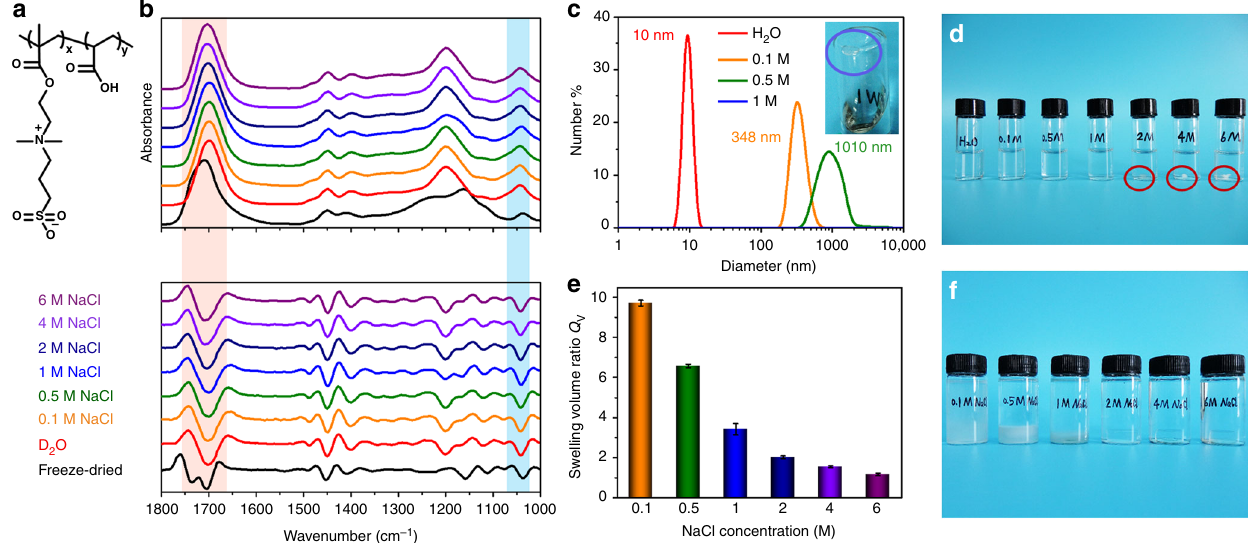
Fig. 1 Con fi rmation of multiple dynamic interactions in the supramolecular networks. a The chemical structure of the polyelectrolyte (PAA-co-DMAPS) synthesized in this work. b ATR-FTIR spectra (in the regions of 1800 – 1000 cm − 1 ) of the freeze-dried PAA-co-DMAPS copolymer and the supramolecular polyelectrolyte hydrogels equilibrated in D 2 O with different NaCl concentrations and their corresponding second derivative curves. c Hydrodynamic diameters of the freeze-dried PAA-co-DMAPS copolymer in aqueous solutions (0.1 wt%) with different NaCl concentrations (0, 0.1, 0.5, and 1 M). The inset photo shows precipitates are observed in 1 M NaCl. d A photo of the PAA-co-DMAPS copolymer equilibrated in aqueous solutions (0.1 wt%) with different NaCl concentrations. e Swelling volume ratios of the polyelectrolyte hydrogels equilibrated in NaCl aqueous solutions with different concentrations. (error bars: standard deviations). f A corresponding photo of the hydrogels in